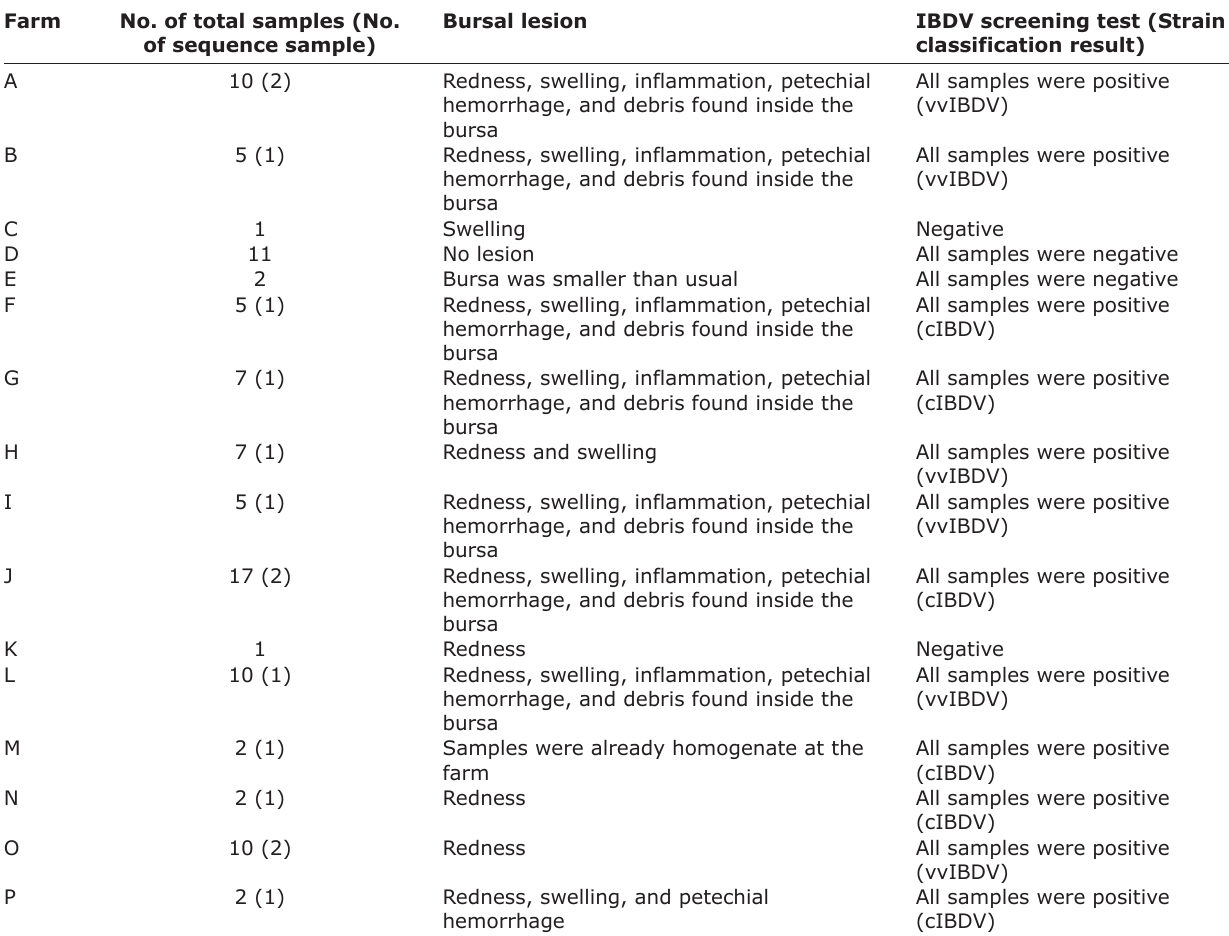
(protocol number IBC1931001). Table-1: Bursa of Fabricius samples collected from farms in Thailand from April 2017 to October 2019. Farm No. of total samples (No. Bursal lesion IBDV screening test (Strain of sequence sample) classification